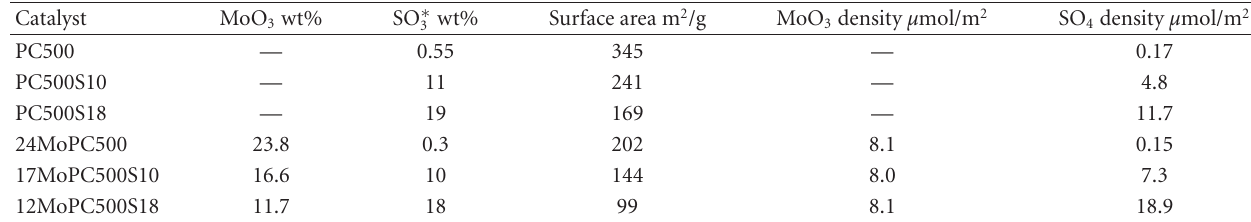
Table 1: List of catalysts and their